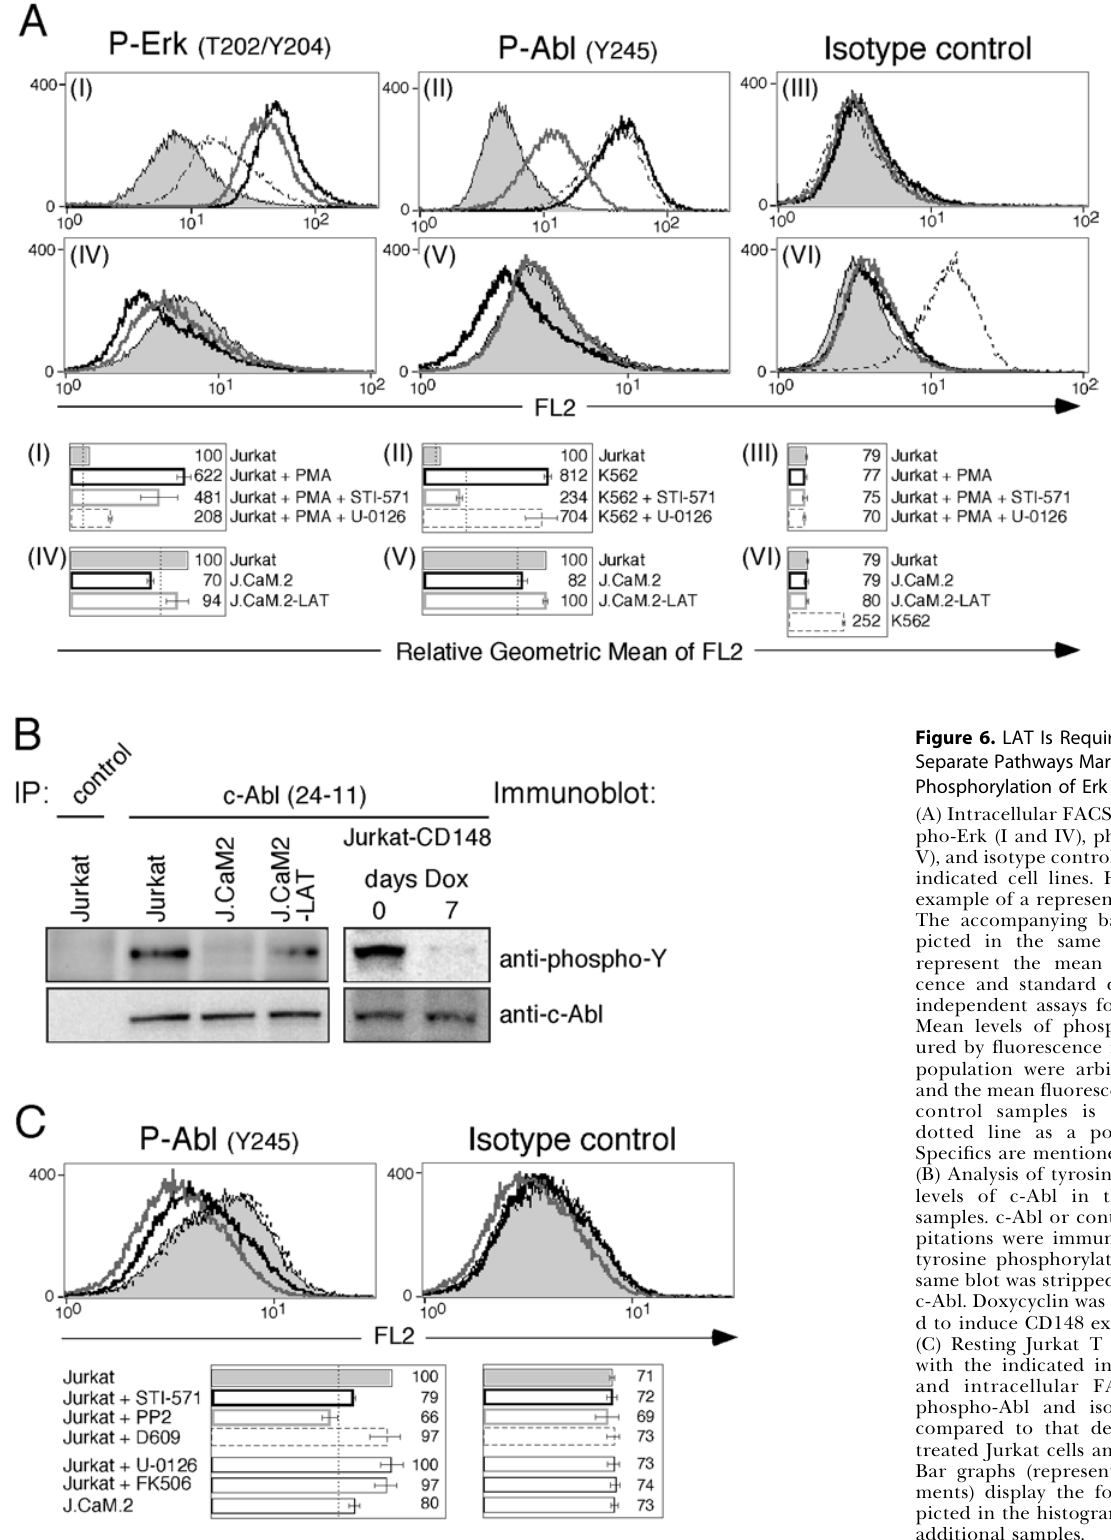
control samples is indicated by the dotted line as a point of